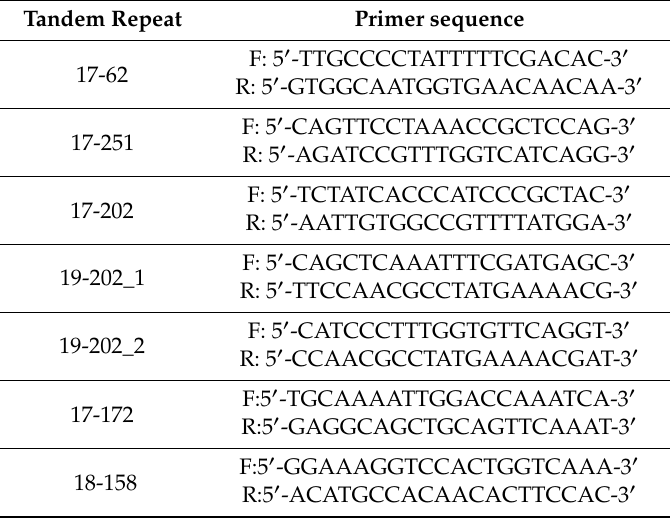
Table 2. Primer sequences for the tandem repeats.